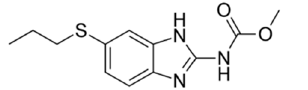
Figure 1. Chemical structure of albendazole.